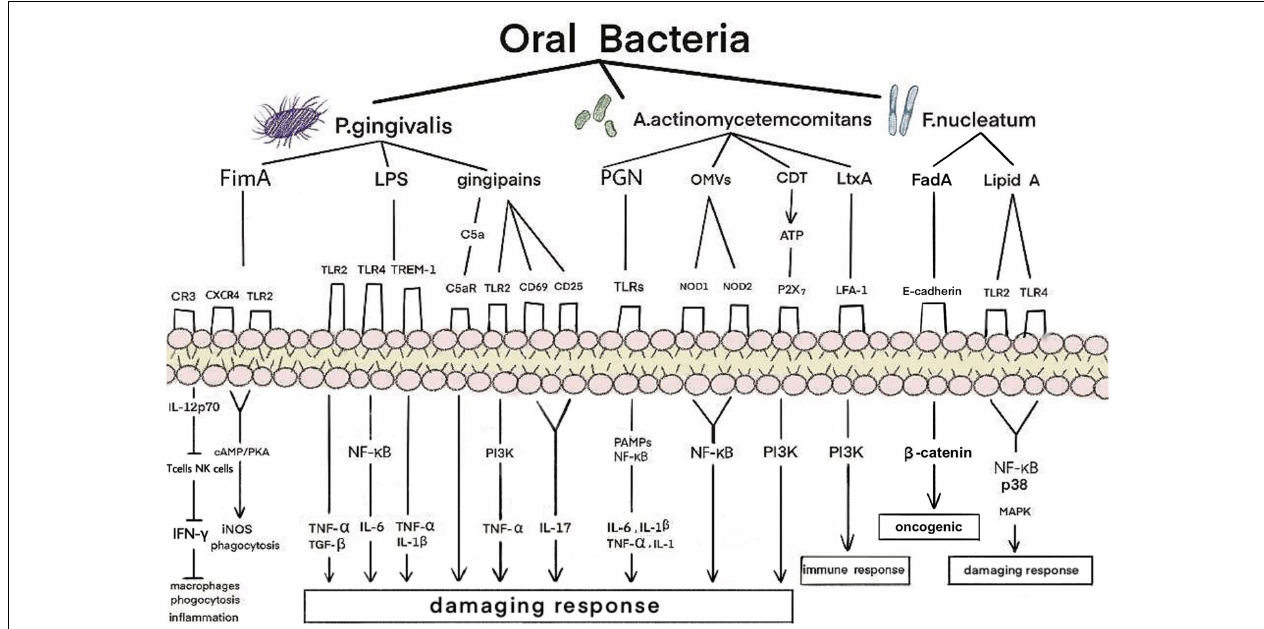
FIGURE 1 | Mechanism of oral bacteria on kidney in patients with periodontitis. P. gingivalis , A. actinomycetemcomitans , and F. nucleatum have adverse effects on the kidneys. P. gingivalis produces an inflammatory response mainly through the combination of fimbriae proteins, LPS and gingipains with corresponding receptors. A. actinomycetemcomitans bind to the corresponding receptors through PGN, OMVs, CDT, and LtxA, and generate damaging and immune responses through the PAMPs, NF- κ B, and PI3K signaling pathway. F. nucleatum bind to the corresponding receptors through FadA and lipidA and produce oncogenic and damaging response through the NF- κ B, p38, and MAPK signaling pathway. LPS, lipopolysaccharide; OMVs, outer membrane vesicles; CDT, cytolethal distending toxin; LtxA, leukotoxin; CXCR4, CXC-chemokine receptor 4; TREM-1, trigger receptor on myeloid cells 1; LFA-1, lymphocyte function-associated antigen 1; CR, complement receptor; TLR, toll-like receptor; iNOS, inducible NO synthase; cAMP, cyclic adenosine monophosphate; PKA, protein kinase A; NF- κ B, nuclear factor kappa B; TNF- α , tumor necrosis factor- α ; TGF- β , transforming growth factor- β ; IL, interleukin; PAMPs, pathogen-associated molecular patterns; PI3K, phosphatidylinositol-4,5-bisphosphate 3-kinase; FadA, Fusobacterium adhesion; MAPK, mitogen-activated protein